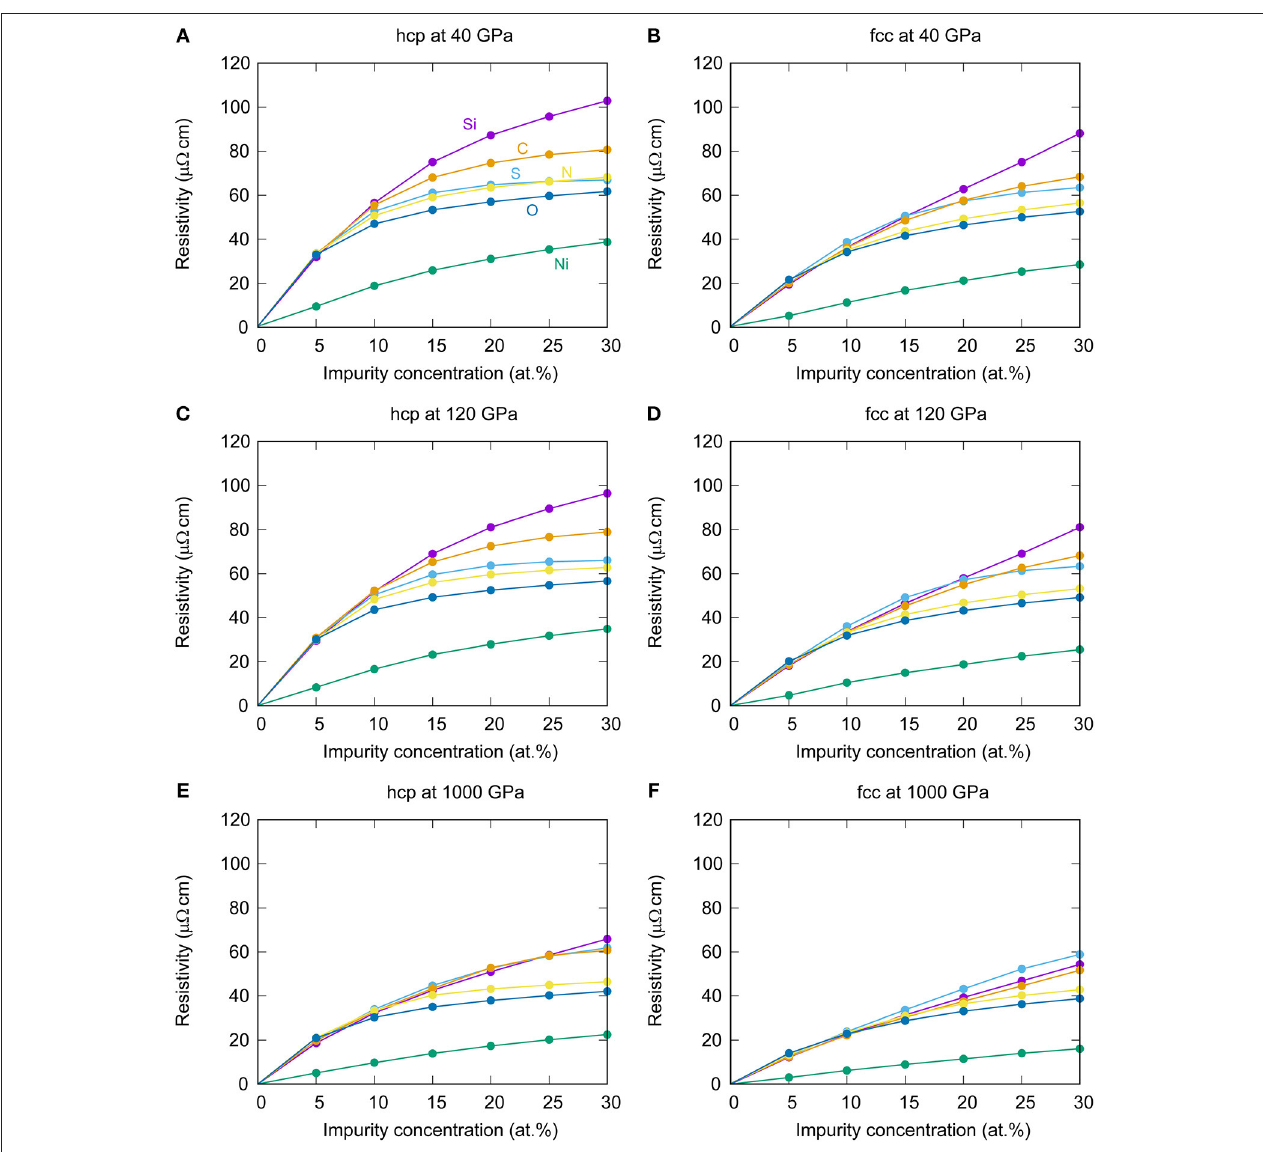
FIGURE 3 | Impurity resistivities of concentrated Fe based alloys (A) hcp at 40 GPa, (B) fcc at 40 GPa, (C) hcp at 120 GPa, (D) fcc at 120 GPa, (E) hcp at 1000 GPa, (F) fcc at 1000 GPa. The alloying elements are Si (purple), Ni (green), S (cyan), C (orange), N (yellow) and O